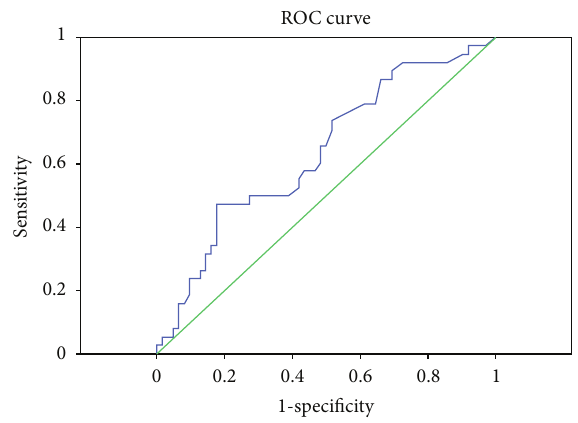
Figure 1: Receiver operating characteristic (ROC) curve validating psychosocial predictive model [2] on CCCP patient population.